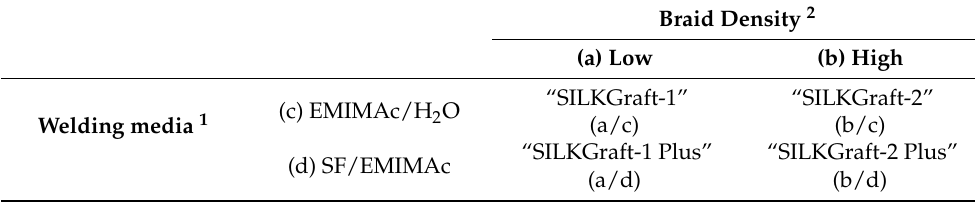
Table 1. Acronyms of the design variants of